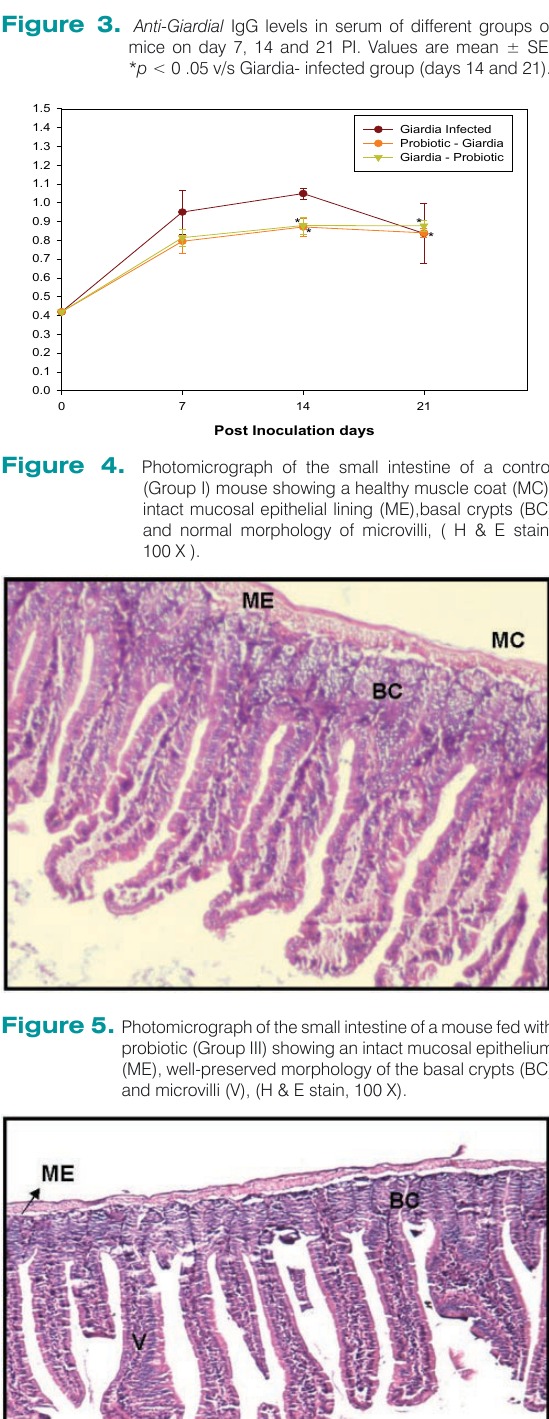
Figure 3. Anti-Giardial IgG levels in serum of different groups of mice on day 7, 14 and 21 PI. Values are mean ± SE, * p < 0 .05 v/s Giardia- infected group (days 14 and 21).